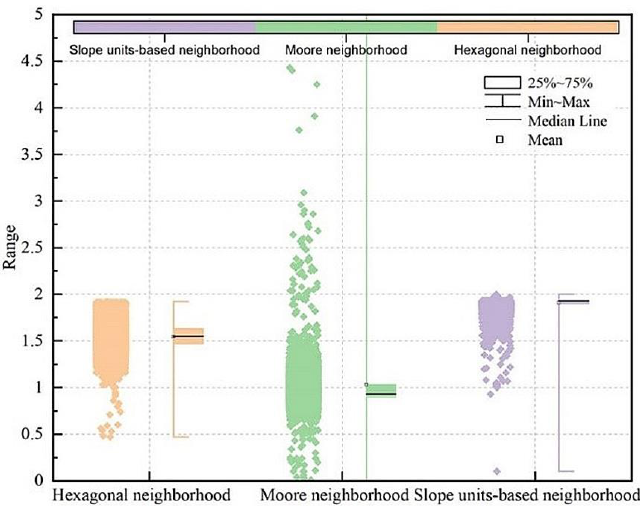
Figure 5. Boxplot of F value distribution of spatial proximity expressions.